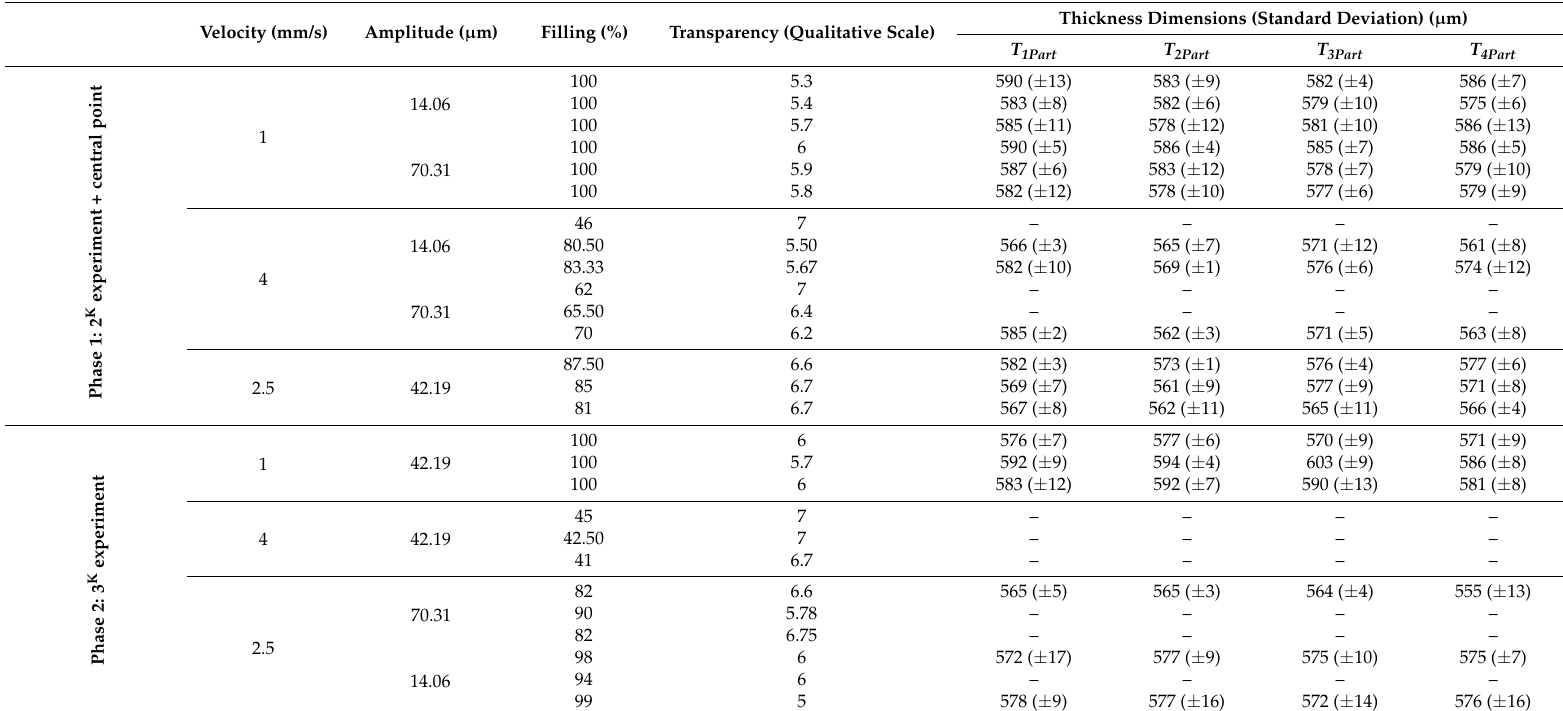
Table 3. Summary of the experimental results; k =